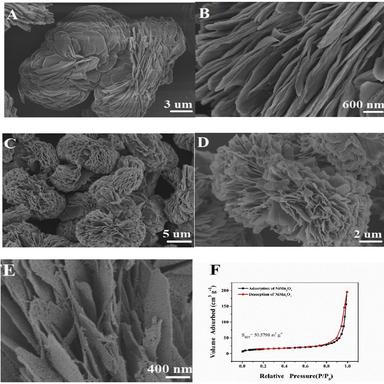
(A, B)Typical SEM images of Mn/Ni-MOFs; (CeE) Typical SEM images of MnNi2O4; (F) N2 adsorption-desorption isotherms of MnNi2O4.